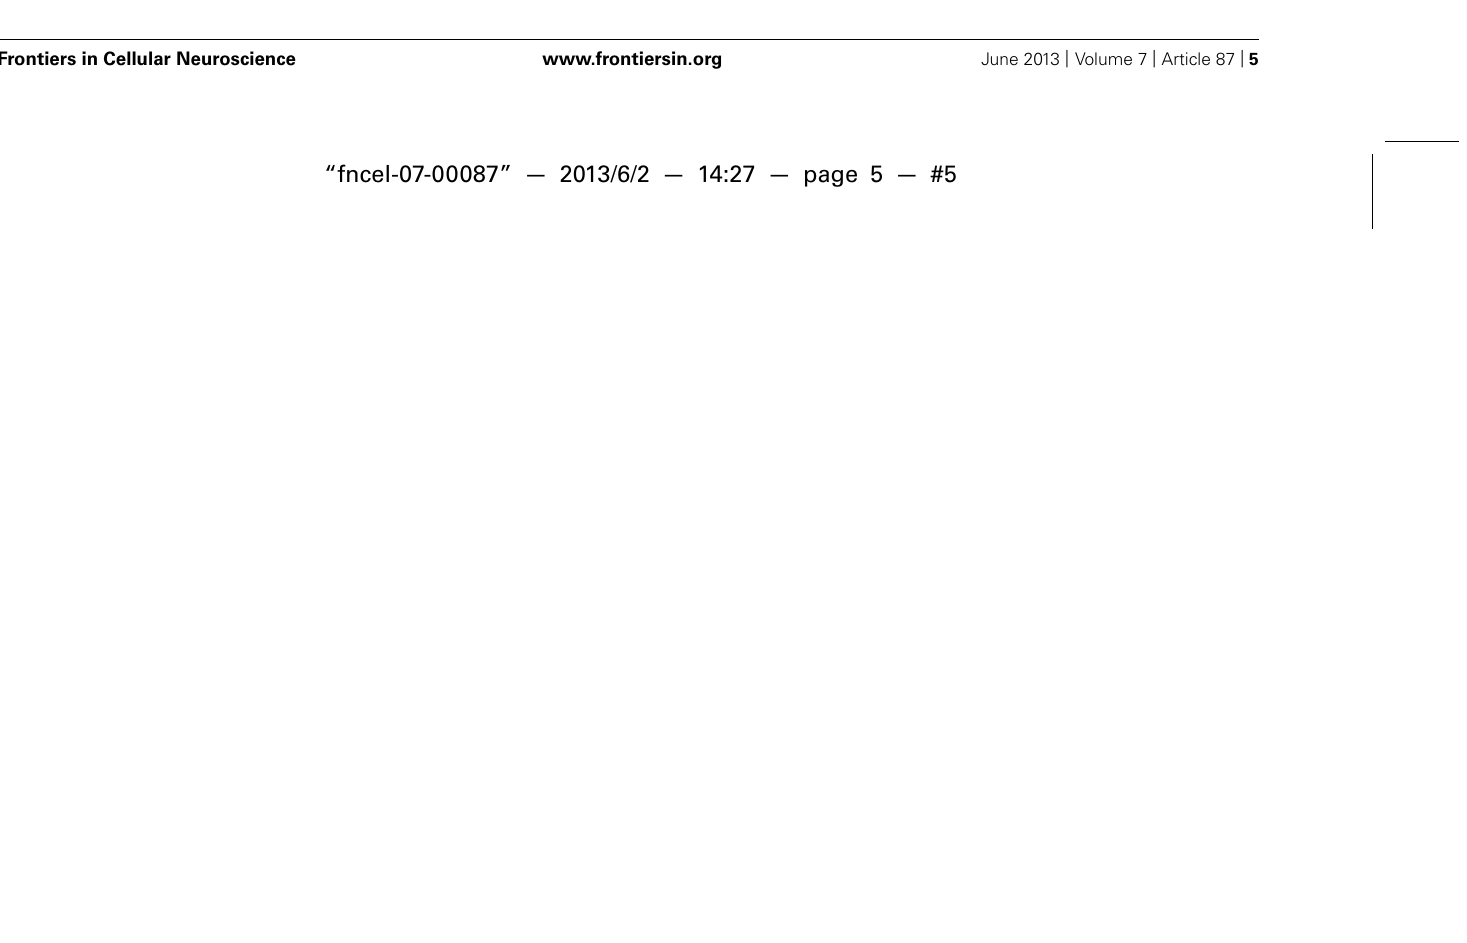
FIGURE 3 | Roles of BMP signaling in neural development. Initially, inhibition of BMP signaling is required for neuroectoderm induction. BMPs generate a signaling gradient and promote dorsomedial identity. BMP signaling is prominent at the dorsal telencephalic midline and in the marginal zone neurons, where it correlates negatively with expression of the cortical selector Lhx2 , Fgf8 , or Shh. In late embryogenesis and postnatally, BMP